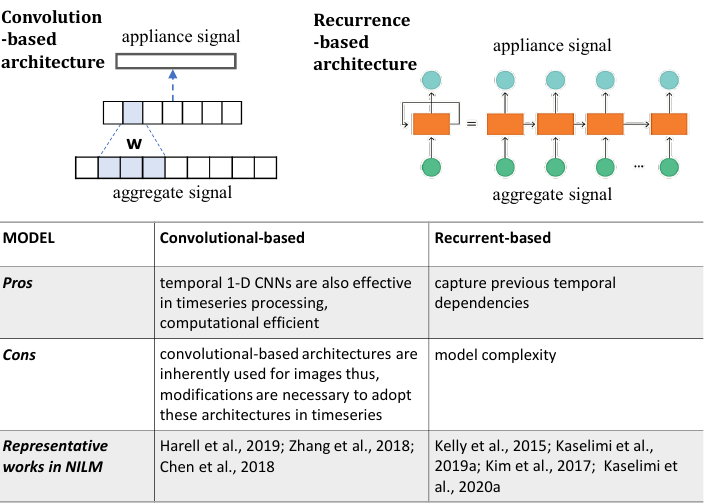
Figure 6. Convolutional or recurrent layers for deep learning models in NILM